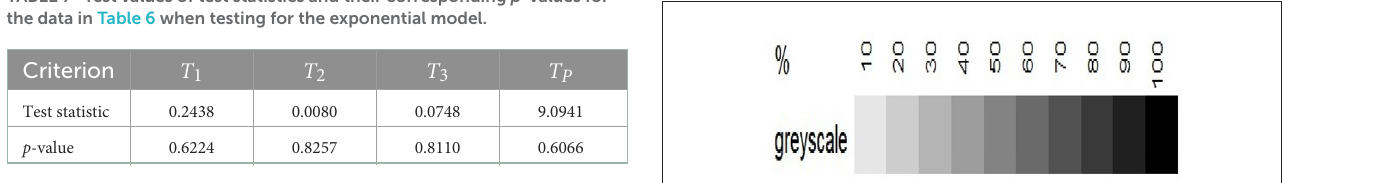
FIGURE7 The greyscale used in Figures